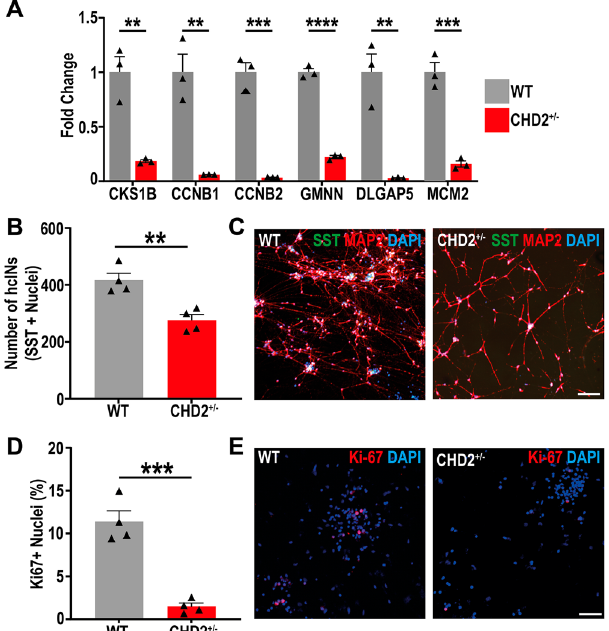
Figure 6. CHD2 haploinsufficiency alters the efficiency of the proliferation to differentiation transition during hcIN differentiation. ( A ) RT-qPCR was used to define the expression in WT and CHD2 +/− cultures at D35 of 6 significantly down-regulated DEGs (as obtained by RNA-seq analysis), that are associated with cell cycle progression. ( B ) Comparison of the numbers of SST immunopositive hcINs in WT versus CHD2 +/− cultures, after plating equivalent numbers of progenitors. Earlier and more efficient differentiation of progenitors resulted in a reduction in the total number of hcINs generated. n = 3 biological replicate experiments. ( C ) Representative images of SST and MAP2 staining in WT and CHD2 +/− D35 cultures. ( D ) The percentage of nuclei that were immunopositive for Ki-67 in the WT versus CHD2 +/− model at D35 of differentiation were defined. n = 3 biological replicate experiments. ( E ) Representative images of D35 cells immunostained for Ki-67. Scale bars = 100 µm. Data is represented as mean ± SEM and was analyzed by Students t -test: ** P < 0.01 *** P < 0.001 **** P < 0.0001 versus